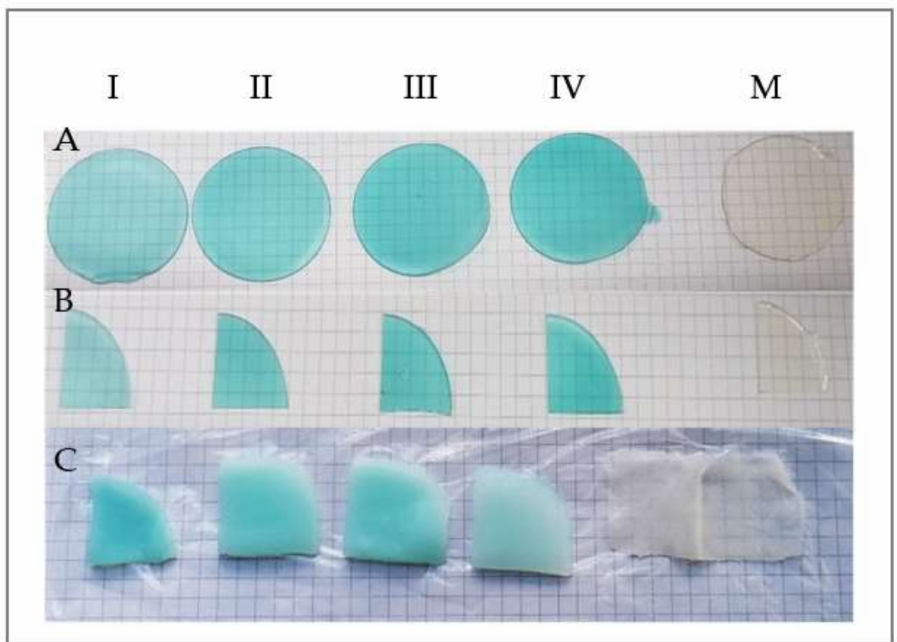
Figure 1. Hydrogels samples. ( A ) dried samples of hydrogels; ( B ) the weighed samples before swelling; ( C ) the samples after 8 days of swelling. M = control sample (0% CuSO 4 × 5H 2 O), I = sample with 0.3906% CuSO 4 × 5H 2 O, II = sample with 0.5469% CuSO 4 × 5H 2 O, III = sample with 0.7031% CuSO 4 × 5H 2 O, IV = sample with 0.8594 CuSO 4 × 5H 2